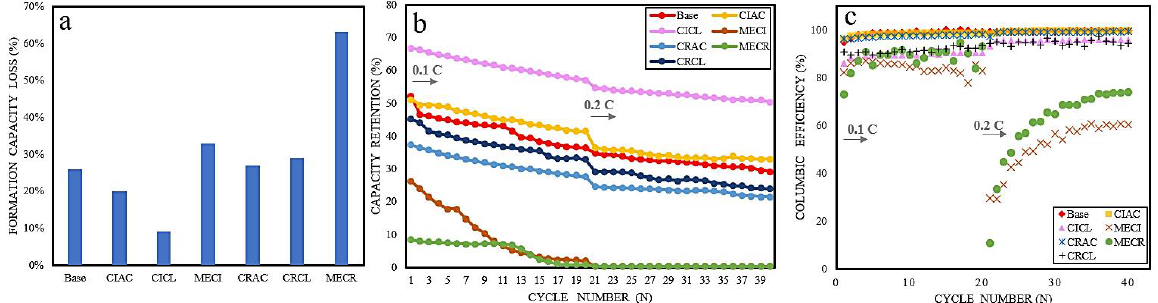
Figure 7. Comparing the cycle performance of the modified electrolytes with the base electrolyte in a full-cell configuration. The initial capacity loss during the SEI formation step ( a ), the capacity retention of the cells after the interphase formation ( b ), and the relevant columbic efficiency ( c ) are shown.